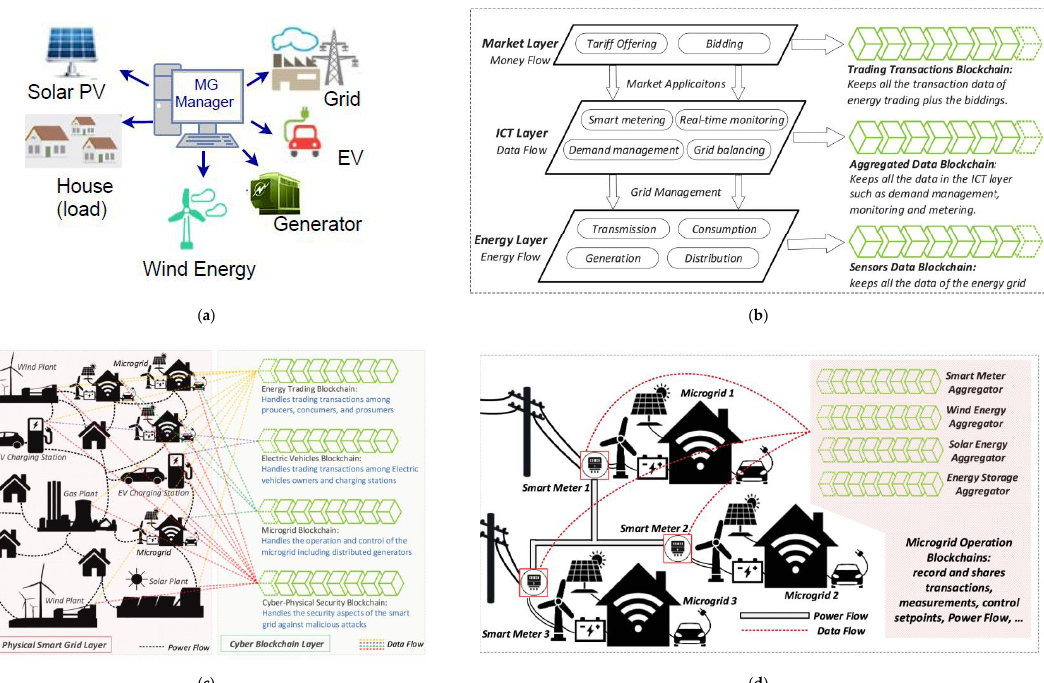
Figure 19. Blockchain for smart grid ( a ). hybrid renewable energy microgrid with microgrid manager (Note: PV—photovoltaics, MG—microgrid, PV—electric vehicle) ( b ). A three-layer blockchain architecture for enhancing security and data protection in a smart grid along with applications (Note: ICT—information and communication technologies) (Reprinted with permission [167], 2019, IEEE). ( c ). A new cyber layer for smart grids using blockchain (Reprinted with permission [167], 2019, IEEE), and ( d ). Using blockchain for microgrid services automation (Reprinted with permission [167], 2019, IEEE).